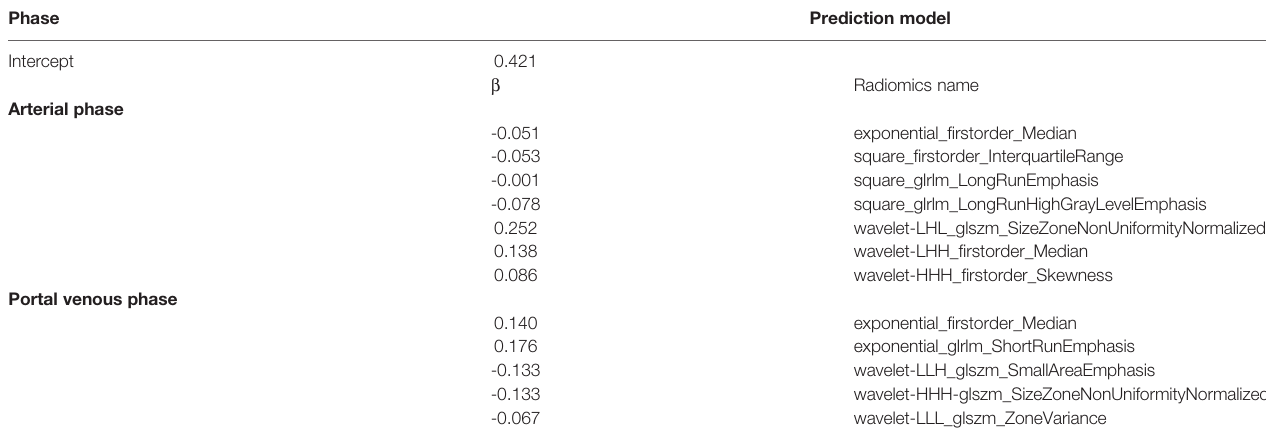
TABLE 2 | The radiomics features selected by Lasso